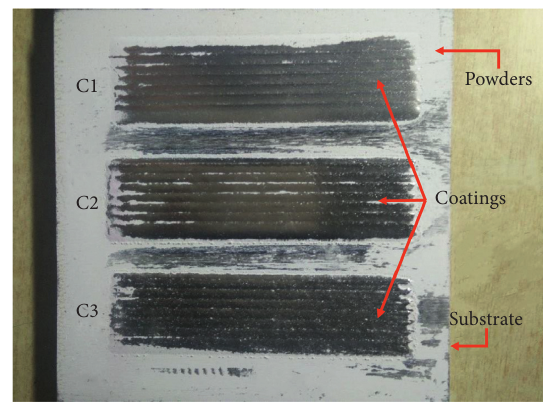
Figure 3: Surface appearance of Ni45 coatings after laser cladding